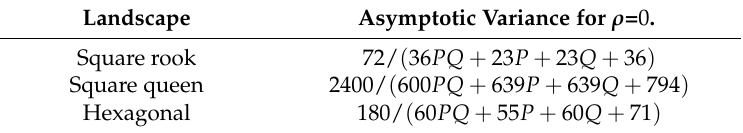
Table 2. Asymptotic variance of ˆ ρ at zero for different surface